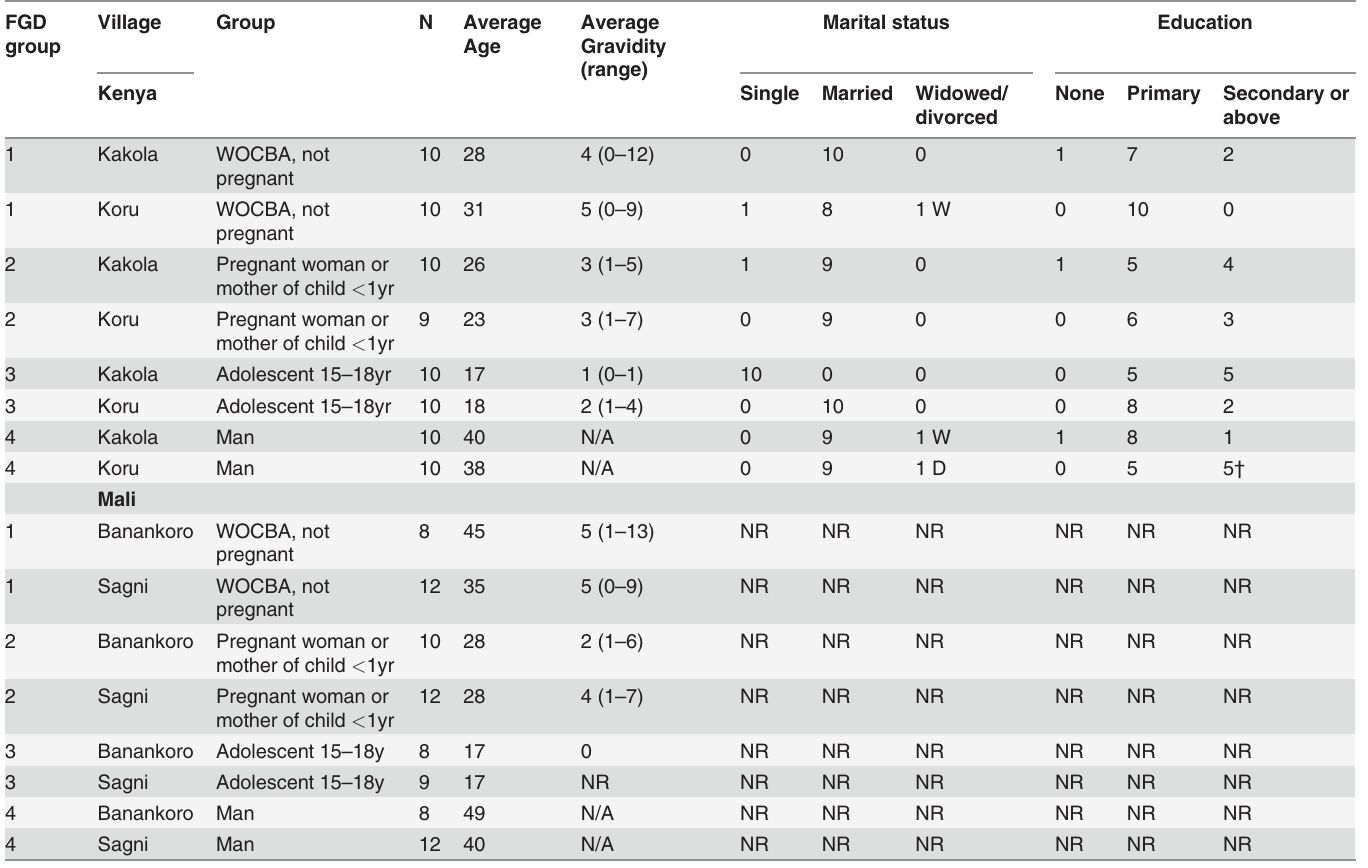
Table 1. Focus group discussion participant